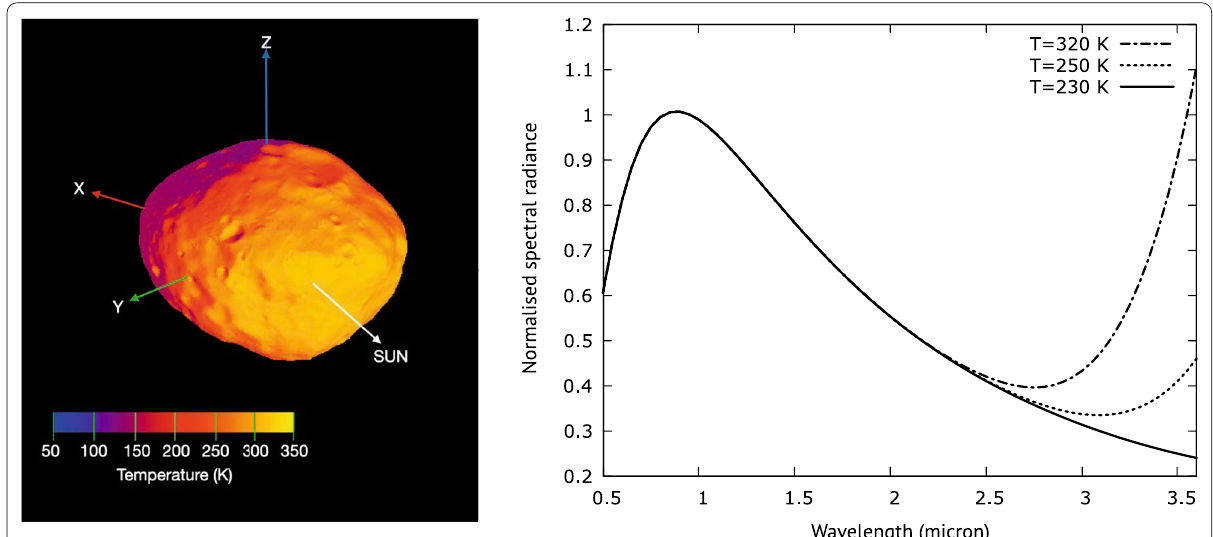
Fig. 2 Left: preliminary temperature calculation on Phobos using the Gaskell shape model (Gaskell 2011). The model was reduced to 98,000 facets to speed‑up calculations. Temperatures decrease from yellow to red to blue. Right: spectral radiance calculated using the thermal model and assuming that the reflected light component is a reddened solar spectrum. The spectral radiance is normalized to 1 at the peak of the curve. Notice the strong thermal tail that arises in MIRS relevant wavelengths and its strong dependence on temperature